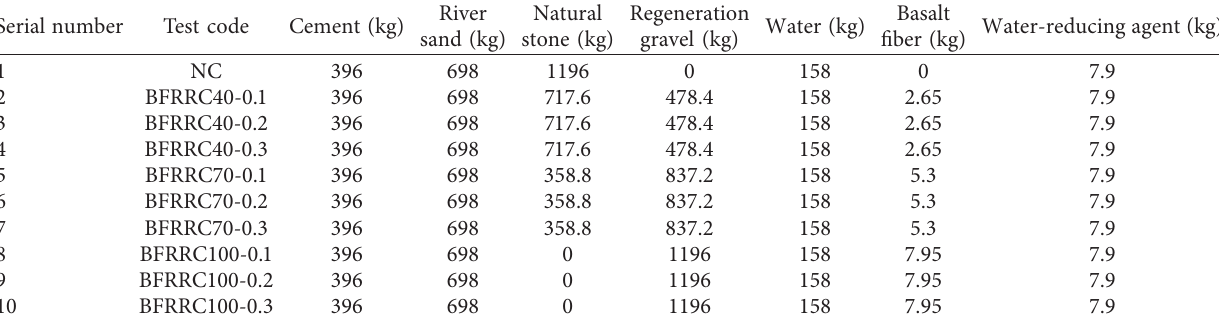
Table 4: Mix proportion design in